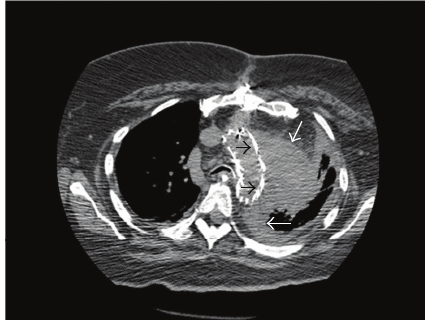
Figure 2: Thoracic stent graft (black arrows) and resolving thoracic hematoma (white arrows).